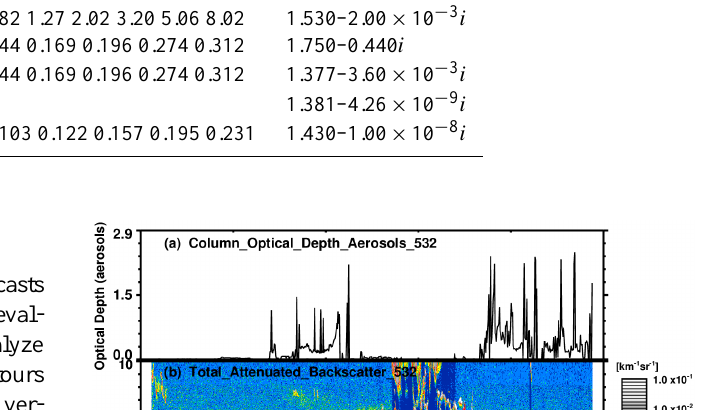
Table 1. Refractive indices ( R eff ) at 0.55 and effective radius of each size bin for different aerosol component in SPRINTARS. Component